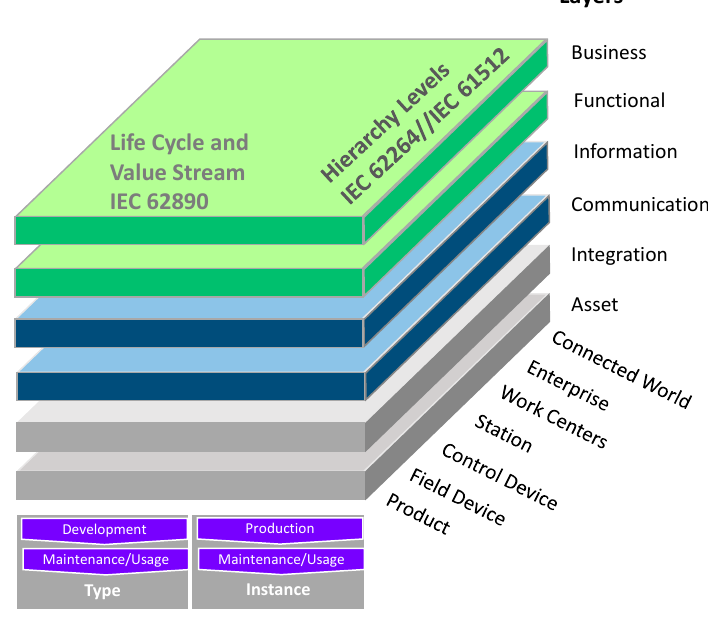
Figure 1. Reference Model for Industrie 4.0 (RAMI 4.0) reference model layers.